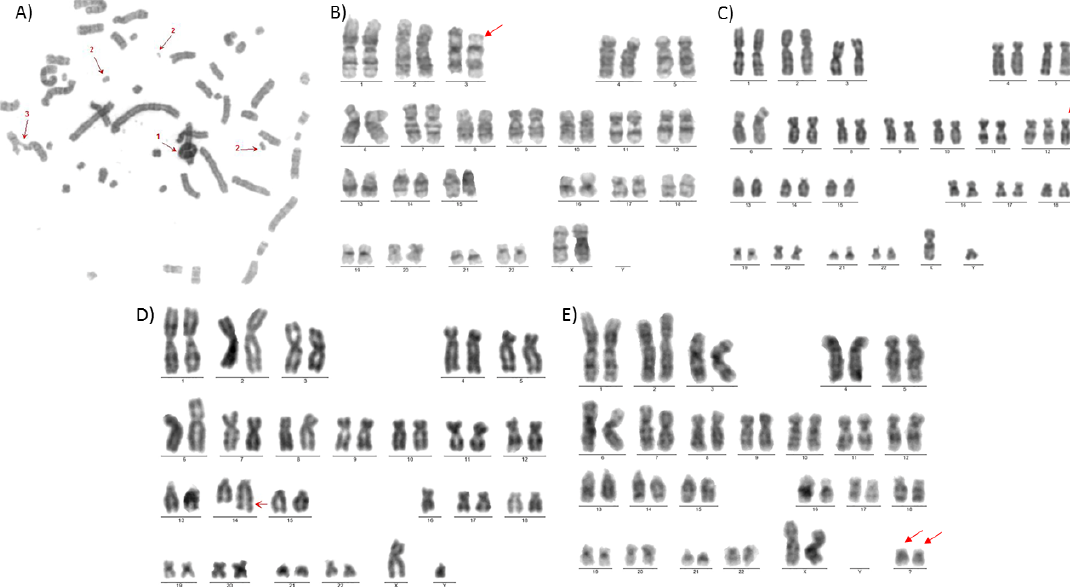
Figure 1 ‒ Cytogenetic analysis. A) Metaphase with ring chromosome (1), double minutes (2) and figure (3) (Sample IP028). B) Karyogram showing chromosome 3 inversion (Sample IP037). C) Karyogram showing chromosome 12 trisomy (Sample IP044). D) Karyogram showing additional material on the long arm of chromosome 14 (Sample IP056). E) Karyogram showing two marker chromosomes (Sample IP039).